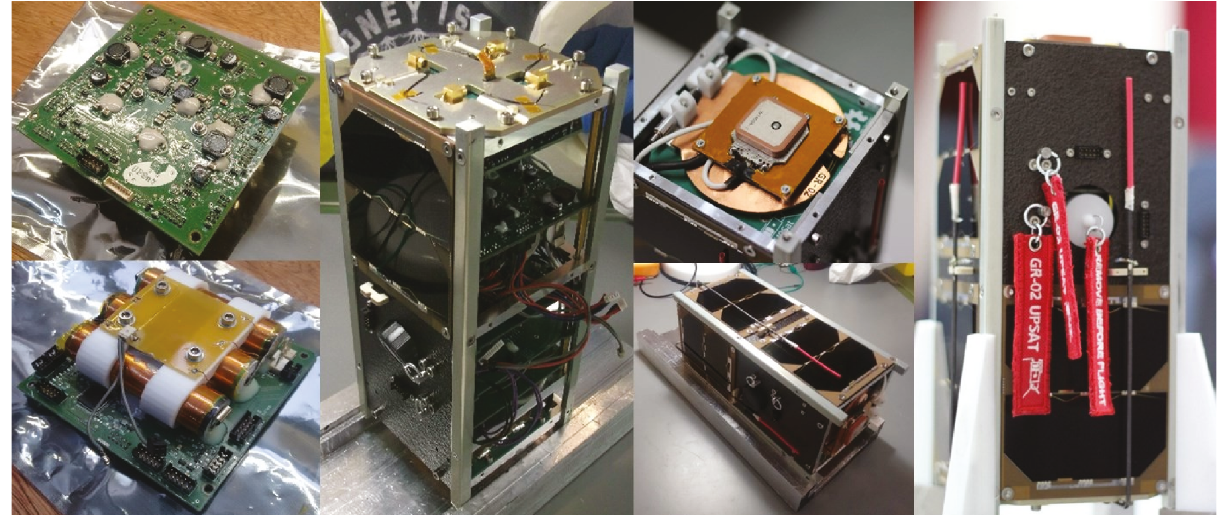
Figure 13: Assembly and integration procedure of UPSAT.